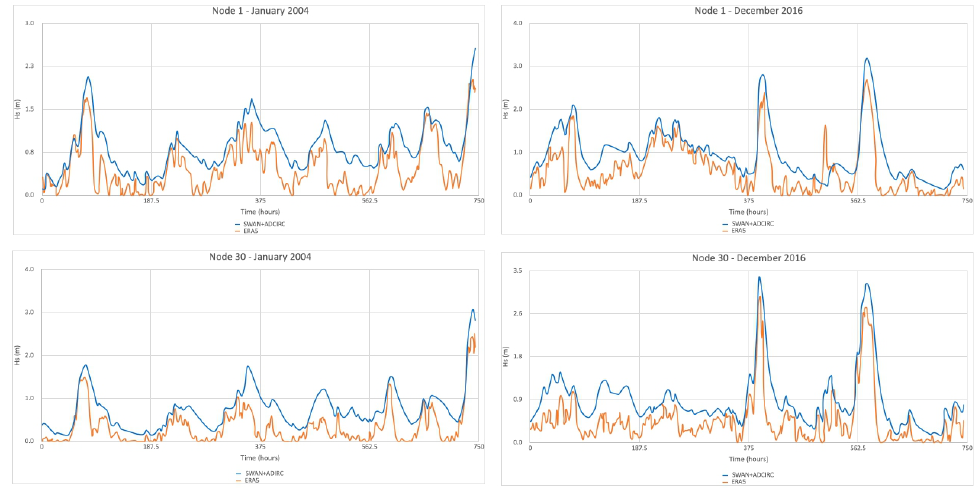
Figure 7. Comparison between significant wave heights calculated in this work with the SWAN + ADCIRC model and significant wave heights of the ERA5 global dataset.